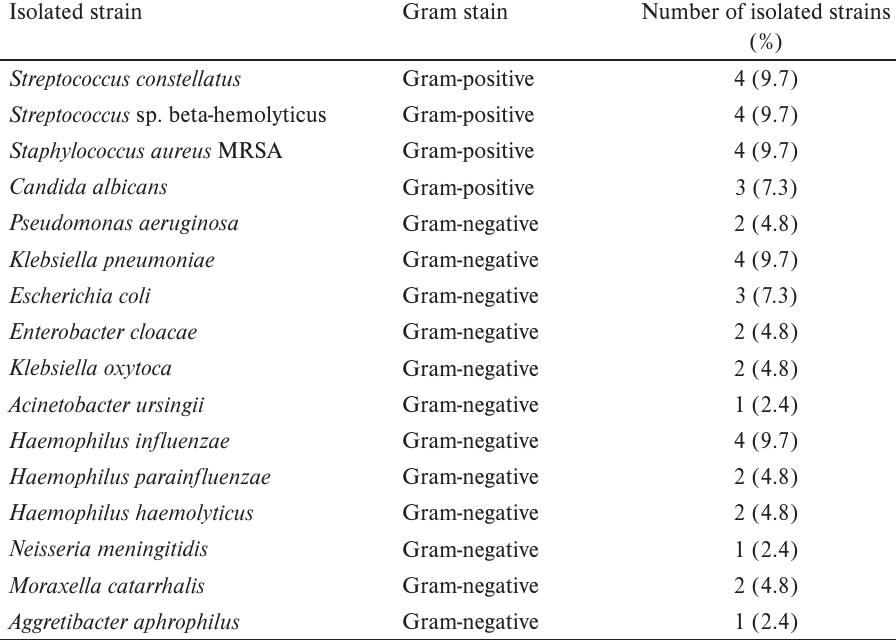
Table 5. Summary of isolated potential microbial pathogens by cultivation of sputum (in samples of 5 patients were isolated more pathogens than one